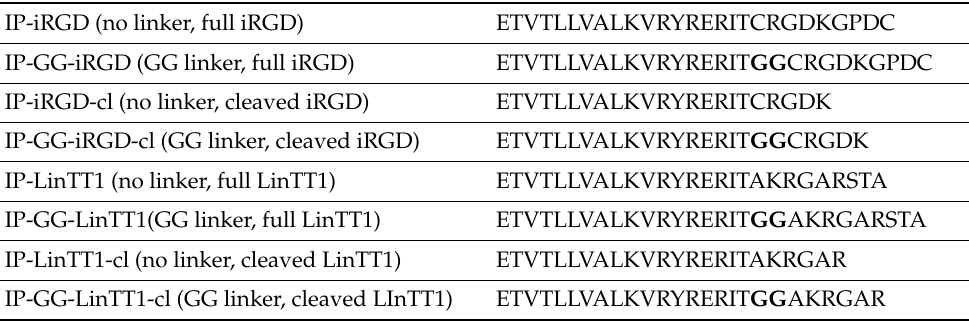
Table 2. Sequences considered for the in silico modeling and simulations. Acronyms for each peptide are specified in column 1 and, by contrast with those of the sequences used for in vitro and in vivo experiments, follow the sequence order. For instance, IP-iRGD-cl is hereafter used for a peptide combining the IP (ETVTLLVALKVRYRERIT) followed by the cleaved TPP (CRGDK) without any linker between the two. Similarly, IP-GG-LinTT1 stands for IP (ETVTLLVALKVRYRERIT) followed by a GG linker, and then by an uncleaved TPP (AKRGARSTA). IP-iRGD (no linker, full iRGD) ETVTLLVALKVRYRERITCRGDKGPDC IP-GG-iRGD (GG linker, full iRGD) ETVTLLVALKVRYRERIT GG CRGDKGPDC IP-iRGD-cl (no linker, cleaved iRGD) ETVTLLVALKVRYRERITCRGDK IP-GG-iRGD-cl (GG linker, cleaved iRGD) ETVTLLVALKVRYRERIT GG CRGDK IP-LinTT1 (no linker, full LinTT1) ETVTLLVALKVRYRERITAKRGARSTA IP-GG-LinTT1(GG linker, full LinTT1) ETVTLLVALKVRYRERIT GG AKRGARSTA IP-LinTT1-cl (no linker, cleaved LinTT1) ETVTLLVALKVRYRERITAKRGAR IP-GG-LinTT1-cl (GG linker, cleaved LInTT1) ETVTLLVALKVRYRERIT GG